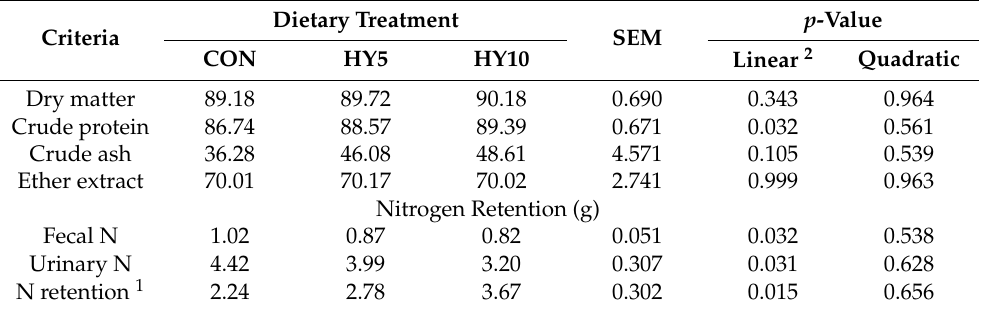
Table 3. Apparent total tract digestibility and nitrogen retention of weaning pigs fed HY- supplemented diet 1